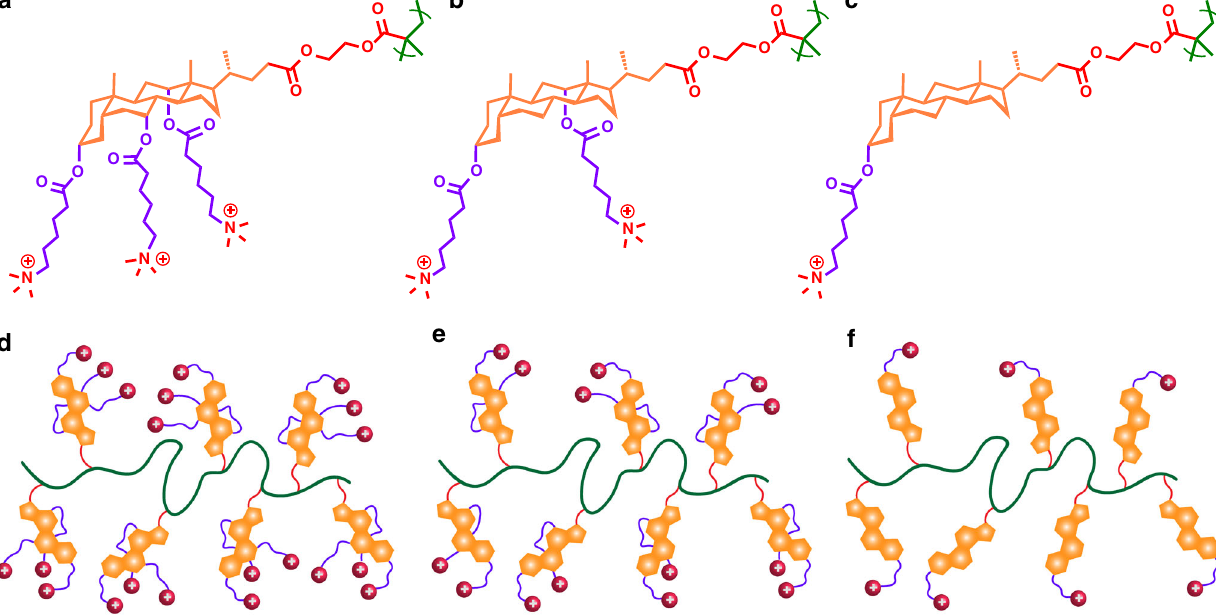
Table 1). The spacer length of methylene (one, three, and fi ve)